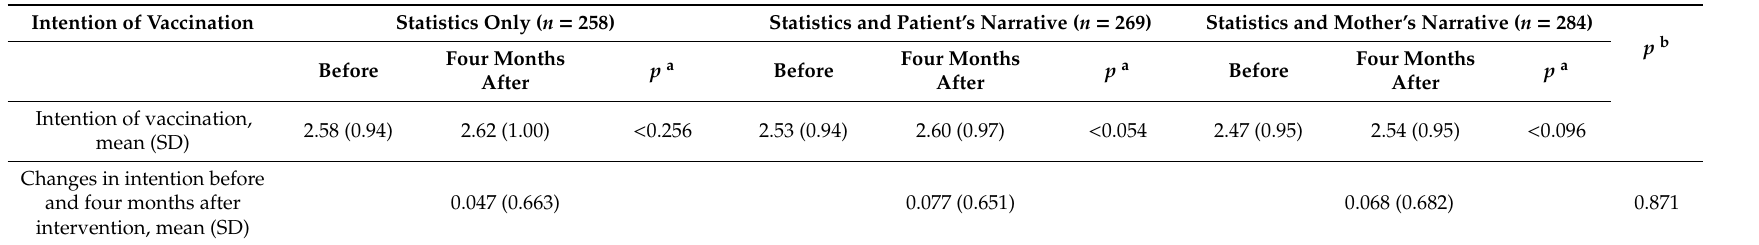
Table 2. Changes in intention of vaccination before and four months after intervention across